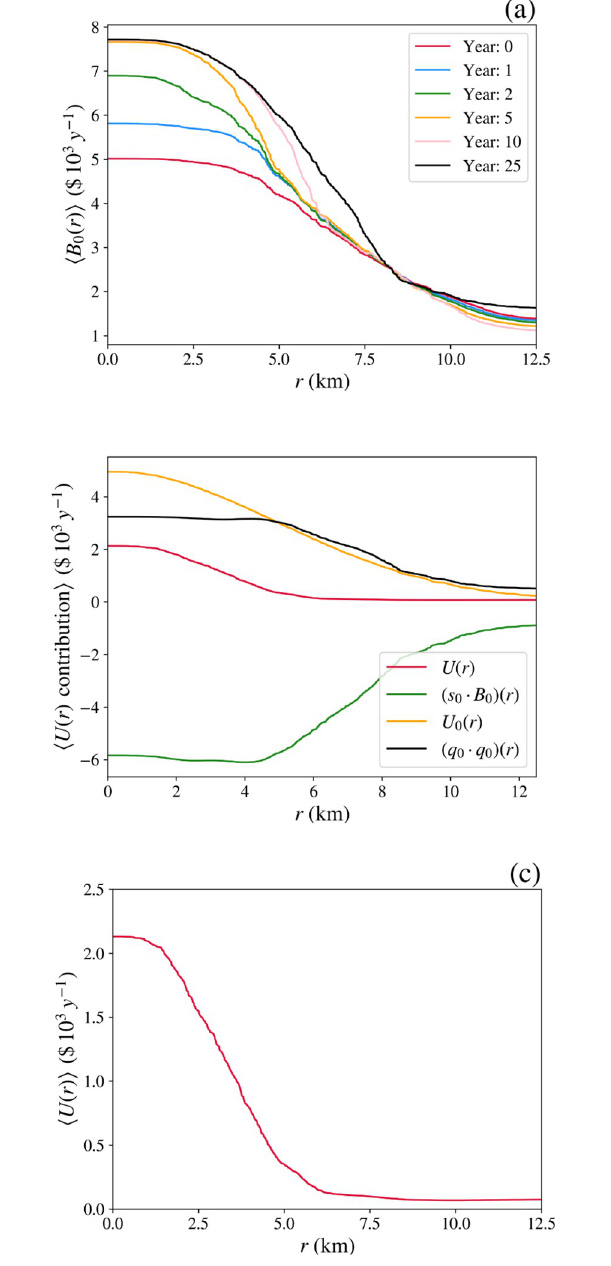
Fig 10. Evolution of contributions to utility vs. distance r from the peak of U 0 , each curve smoothed to remove short-scale fluctuations for clarity. ( a ) Mean dwelling price B 0 ( r ) at various times indicated by the legend. The plot at t = 0 years occurs just after dwelling assignment; prior to dwelling assignment, B 0 is uniformly zero and is not shown explicitly. ( b ) Contributions to mean household utility U ( r ), as indicated by the legend. ( c ) Expanded view of mean household utility U ( r ) as a function of distance r from the maximum of U 0 at (12.5, 12.5), as indicated by the legend.